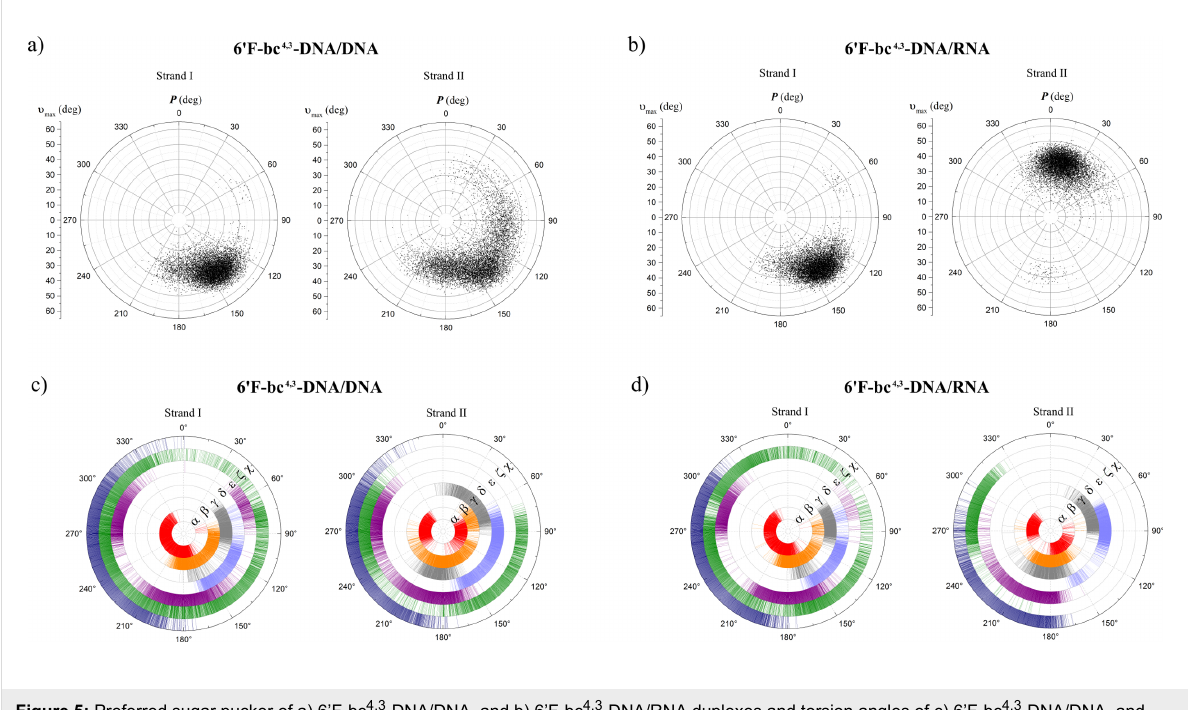
Figure 5: Preferred sugar pucker of a) 6’F-bc 4,3 -DNA/DNA, and b) 6’F-bc 4,3 -DNA/RNA duplexes and torsion angles of c) 6’F-bc 4,3 -DNA/DNA, and d) 6’F-bc 4,3 -DNA/RNA duplexes extracted from a 100 ns molecular dynamics